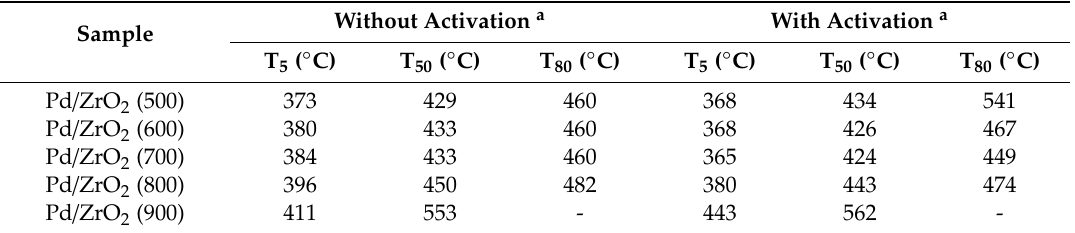
Figure 3. Temperature-programed reactions over the Pd/ZrO 2 (x) catalysts ( A ) without pretreatment, Figure3. Temperature-programedreactionsoverthePd / ZrO 2 (x)catalysts( A )withoutpretreatment, and and ( B ) with pretreatment period: ( a ) Pd/ZrO 2 (500); ( b ) Pd/ZrO 2 (600); ( c ) Pd/ZrO 2 (700); ( d ) ( B ) with pretreatment period: ( a ) Pd / ZrO 2 (500); ( b ) Pd / ZrO 2 (600); ( c ) Pd / ZrO 2 (700); ( d ) Pd / ZrO 2 (800); Pd/ZrO 2 (800); and ( e ) Pd/ZrO 2 (900) catalysts. The reactant composition and the total flow rate were and ( e ) Pd / ZrO 2 (900) catalysts. The reactant composition and the total flow rate were fixed as 10 vol.% fixed as 10 vol.% H 2 O/0.1% CH 4 /3.15% O 2 /N 2 balance and 400 cm 3 /min (GHSV = 240,000 cm 3 g − 1 h − 1 ), H 2 O / 0.1% CH 4 / 3.15% O 2 / N 2 balance and 400 cm 3 / min (GHSV = 240,000 cm 3 g − 1 h − 1 ), respectively. respectively. Table 2. Catalytic performances of the Pd / ZrO 2 (x) catalysts obtained from the temperature-programed